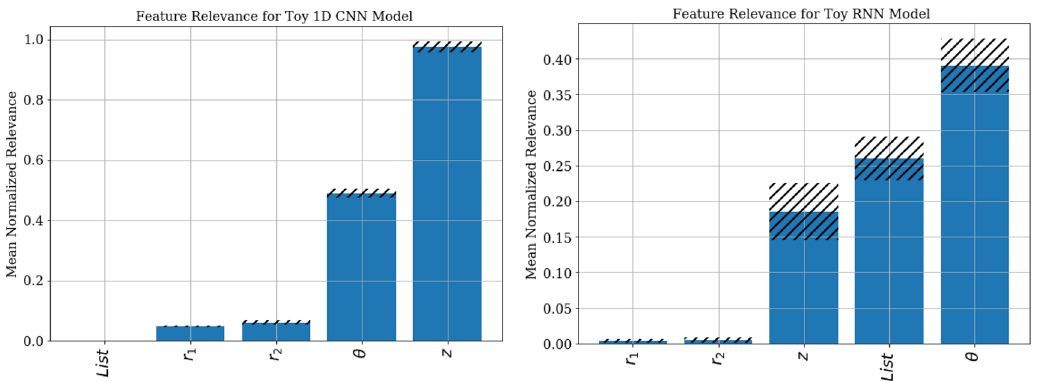
Figure 16. Mean normalized relevance score for 4 trainings of the toy 1D CNN (toy 1D RNN) on the left(right), where the relevance scores of constituent variables List ( δα 1 , δβ 1 , δα 1 , δα 2 , z const , 1 , z const , 2 ) are